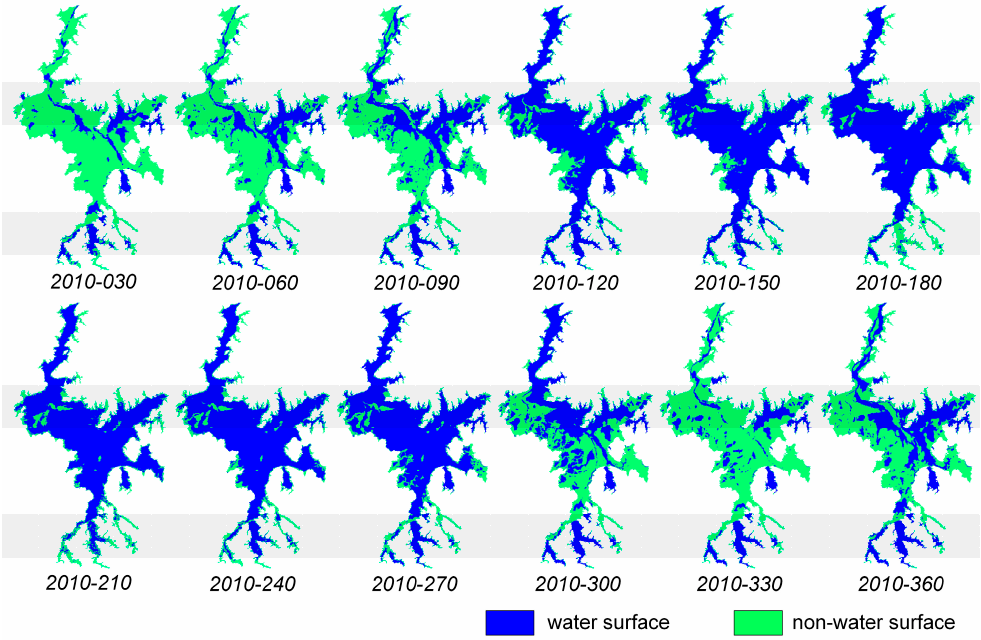
Figure 9. Monthly water surfaces for the Poyang Lake in 2010 (flooding year). Lake surfaces are derived using the MinVC NDVI.